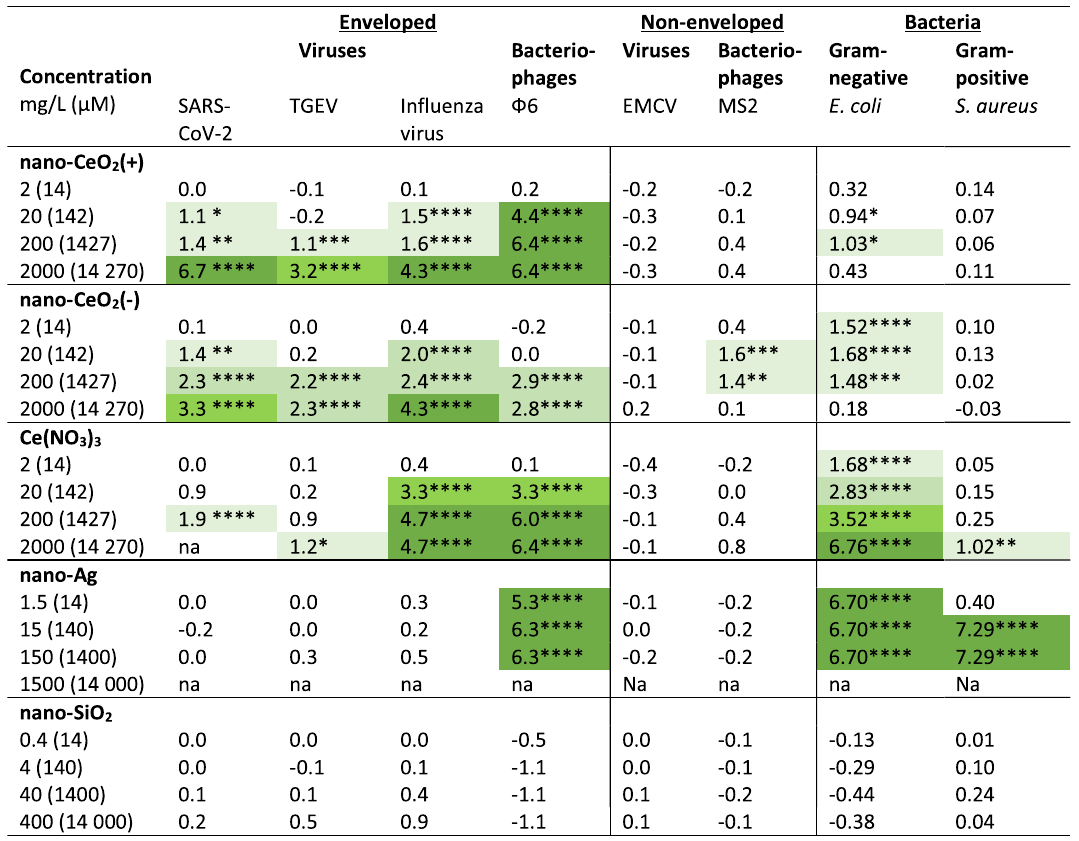
Table 3. Antiviral or bactericidal activity at different concentrations of nanoparticles and Ce(NO 3 ) 3 (numerical data from Figs. 4, 6). Antiviral activity is expressed as log reduction in infectious viral titer compared to unexposed control after 1 h. Bactericidal activity is expressed as log reduction in viable counts compared to unexposed control after 1 h. Concentrations causing at least 1 log (90%), 2 logs (99%), 3 logs (99.9%) and 4 logs (99.99%) decrease are indicated with light to dark green color gradient. A minimum of 2 log reduction (99%) in viable bacterial count or infectious viral titer is generally considered as lowest biologically meaningful activity in antimicrobial applications while at least 4 log reduction within up to 1 h is required from biocidal products in suspension tests in the framework of European legislation 64 . *p < 0.05, **p < 0.01, ***p < 0.001 and ****p <